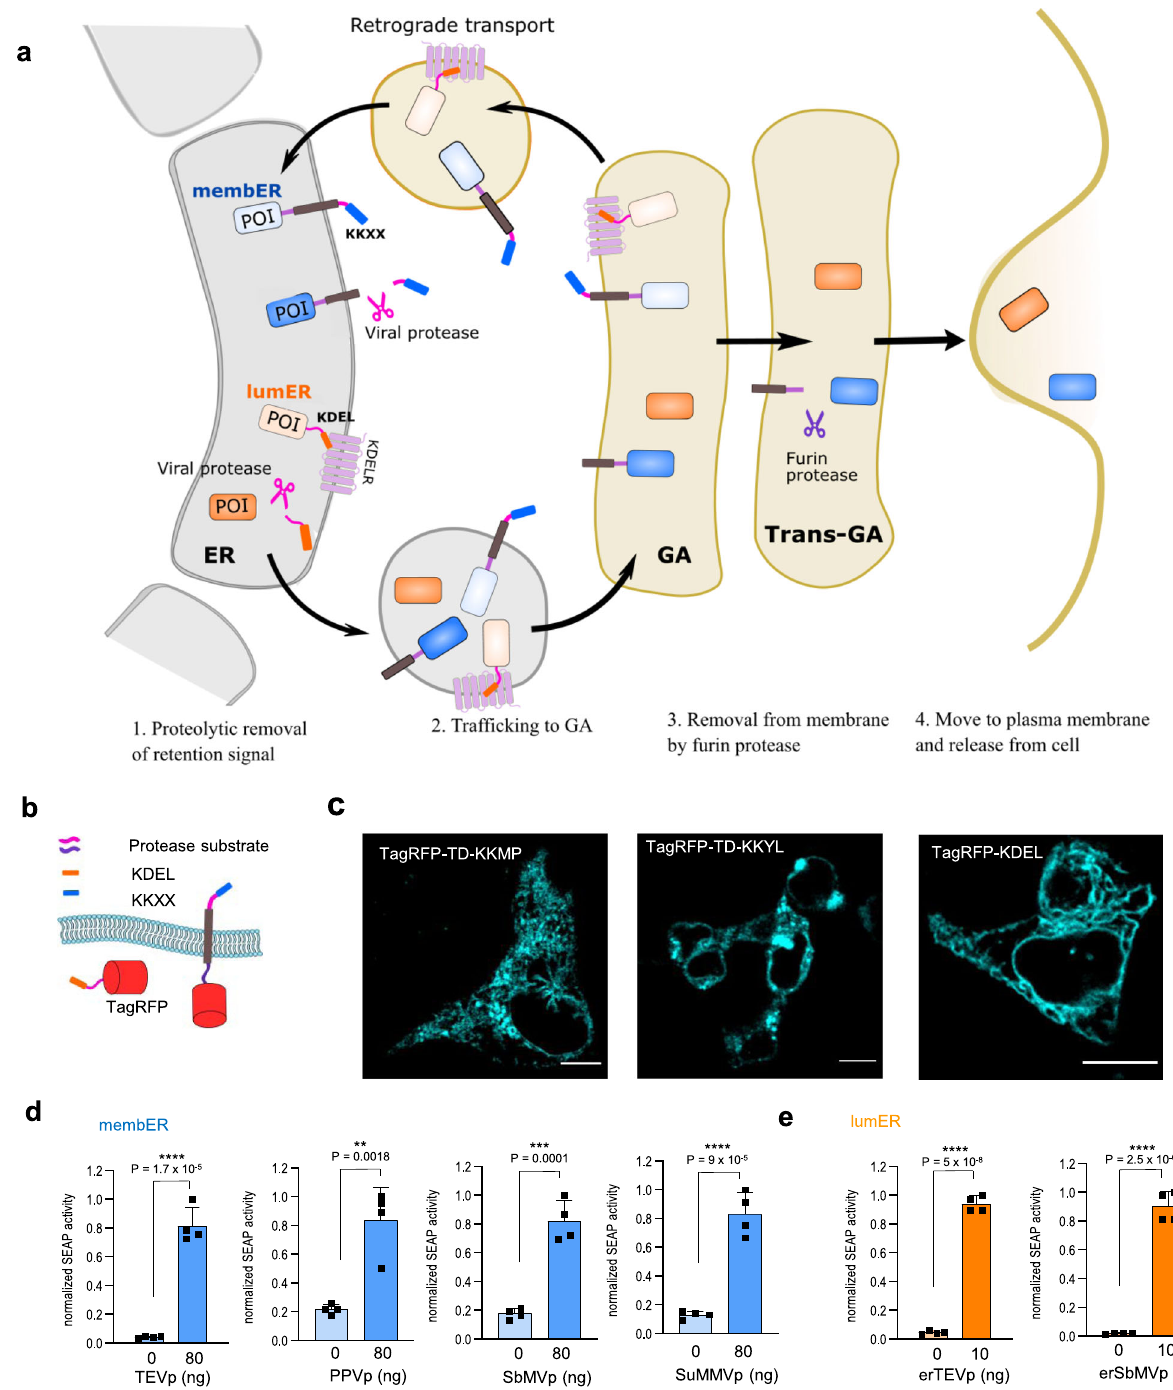
Fig. 1 Protease-inducible protein secretion by the membER and lumER systems. a Protease-triggered secretion of pre-synthesized protein from the ER is achieved by the cleavage of the C-terminal ER retention signal. A speci fi c and orthogonal potyviral protease cleavage site was inserted between the protein of interest (POI) and the ER retention signal. Secretion is induced by the cytosolic protease (KKXX, membER system) or ER-localized protease (KDEL, lumER system). A furin protease (FURp) cleavage site (FURs) was inserted between the reporter and transmembrane domain to release the POI from the membrane for the membER system. b Design of the membER and lumER constructs featuring a TagRFP protein, which were used in microscopy imaging. c Imaging of TagRFP, featuring a transmembrane domain and a C-terminal KKMP, KKYL or KDEL sequence. Scale bar = 10 µ m. Images are representative of three independent experiments. d SEAP activity in cell supernatant was measured from cells transfected with membER constructs SEAP-FURs-TM- TEVs-KKYL, SEAP-FURs-TM-PPVs-KKYL, SEAP-FURs-TM-SbMVs-KKYL, or SEAP-FURs-TM-SuMMVs-KKYL and co-transfected with TEVp, PPVp, SbMVp, or SuMMVp, respectively. e SEAP activity in the cell media from cells transfected with lumER constructs SEAP-TEVs-KDEL or SEAP-SbMVs-KDEL was measured after the co-transfection of an ER-localized TEVp (erTEVp) or SbMVp (erSbMVp,) respectively. Values are the mean of four cell cultures ± s.d. An unpaired two-tailed t test (after equal variance was assessed with the F test assuming normal data distribution) was used for the statistical comparison of the data. Results are representative of three independent experiments. Source data are provided as a Source Data fi le. NATURE COMMUNICATIONS| (2022) 13:1323 |https://doi.org/10.1038/s41467-022-28971-9|www.nature.com/naturecommunications